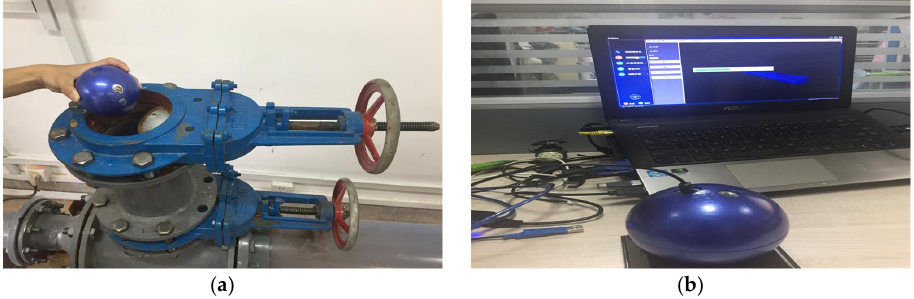
Figure 5. ( a ) Free-swimming device launching in three-way structure ( b ) Acoustic data transferring.